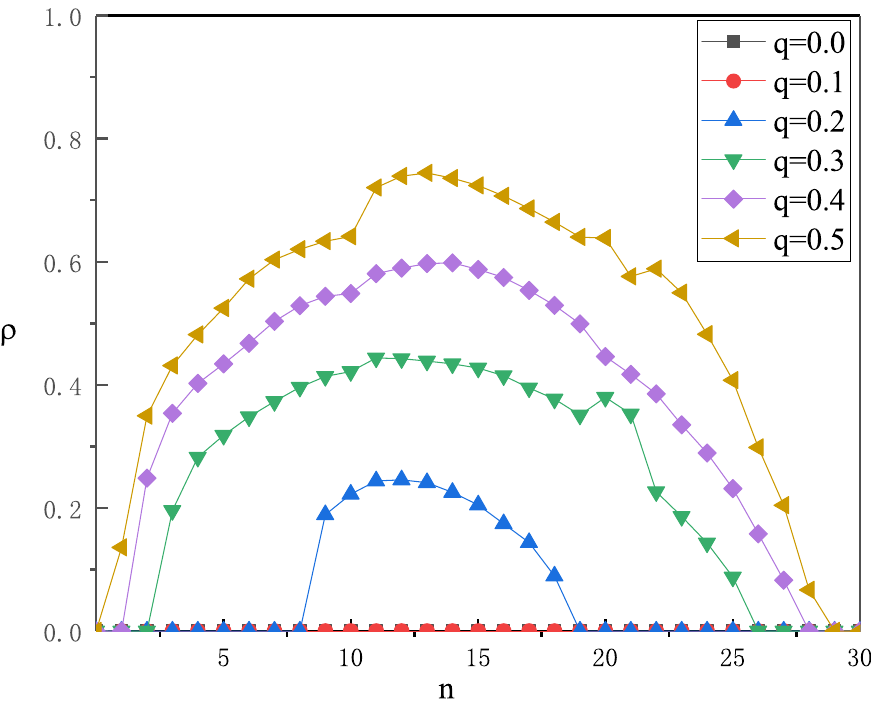
Figure 5. Fraction of cooperators at the stationary state as a function of n for different numbers of information acquisition q when T is fixed to be 1.1. Different color curves denote the results under different q . Other model parameters are fixed to be: L = 100, K = 0.1 and c =